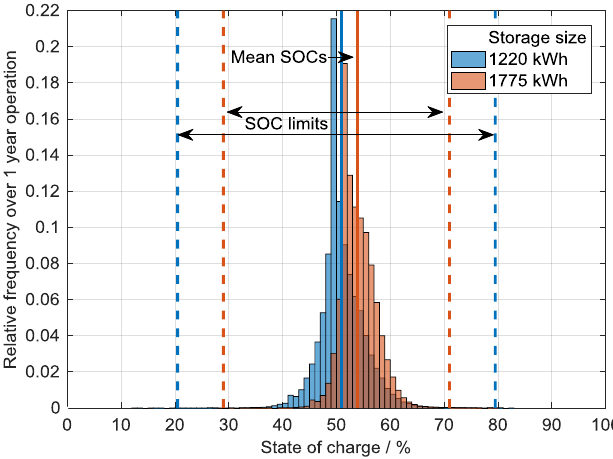
Figure 9. Relative frequency of SoC over one year of operation.